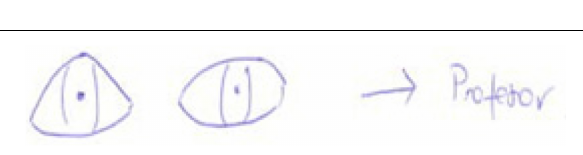
FIGURE 11 | Drawings of the teacher as an orchestra conductor and the pupils as musicians.